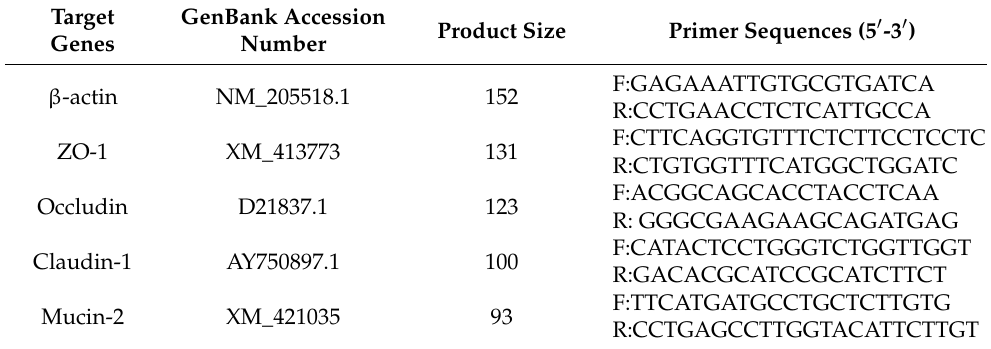
Table 2. Primer sequences of target and housekeeping